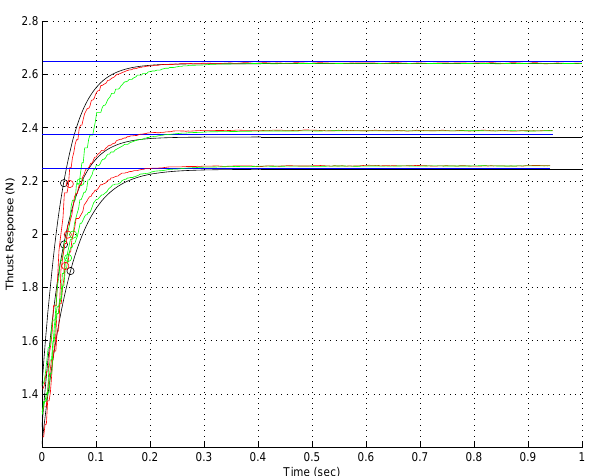
Table 12: Simulated rise times (63%, in ms) for the different test cases and number of propellers. T i is the rise time with i propellers. ∆ T i is age of T a,i and T d,i .